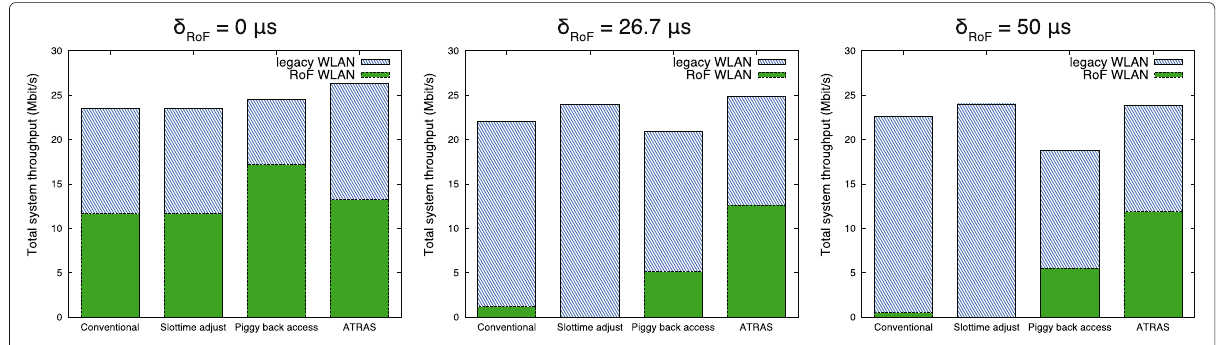
Fig. 12 Total throughput of the RoF-based WLAN and legacy WLAN